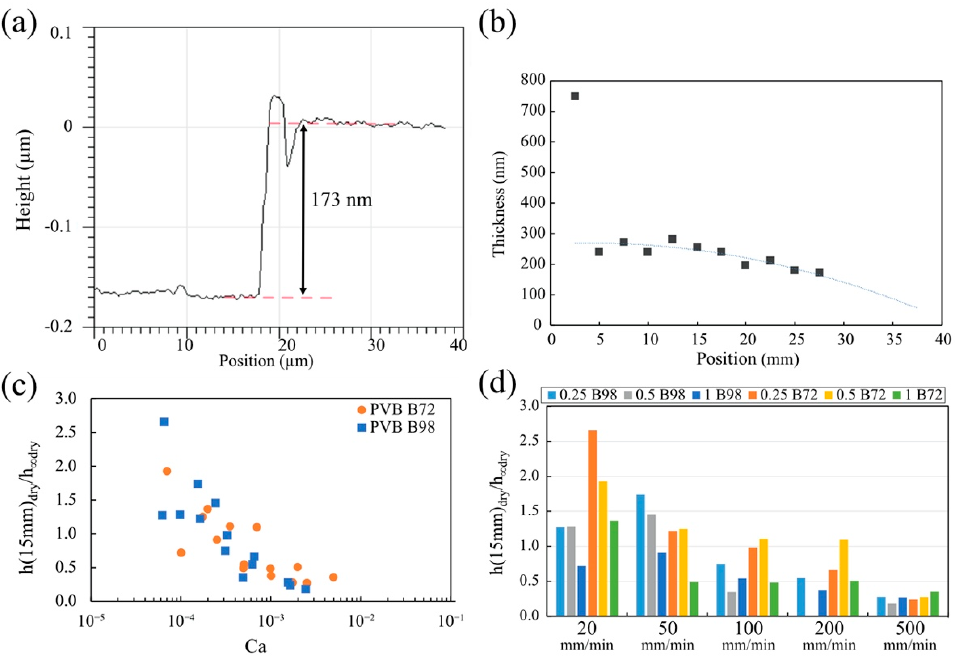
Figure 9. ( a ) The AFM edge profile of the scratched trench. The coating was prepared with 1 g/dL PVB-B72 at a withdrawal velocity of 500 mm/min. ( b ) The profile of the solid film along the vertical direction of the coated plate (position = 0 is at the bottom; position = 35 mm is at the top edge of the coating film). ( c ) The ratio of the measured thickness of the solid film at position 15 mm ( h(15 mm ) dry ) and the thickness based on LLD theory h_ ∞ dry (defined in Equations (8) and (9) vs. the capillary number. ( d ) The ratio of the measured thickness of the solid film at position 15 mm ( h(15 mm ) dry ) over the “dry” coating thickness based on LLD theory h ∞ dry (defined in Equations (8) and (9)) for different polymer concentrations and withdrawal velocities.